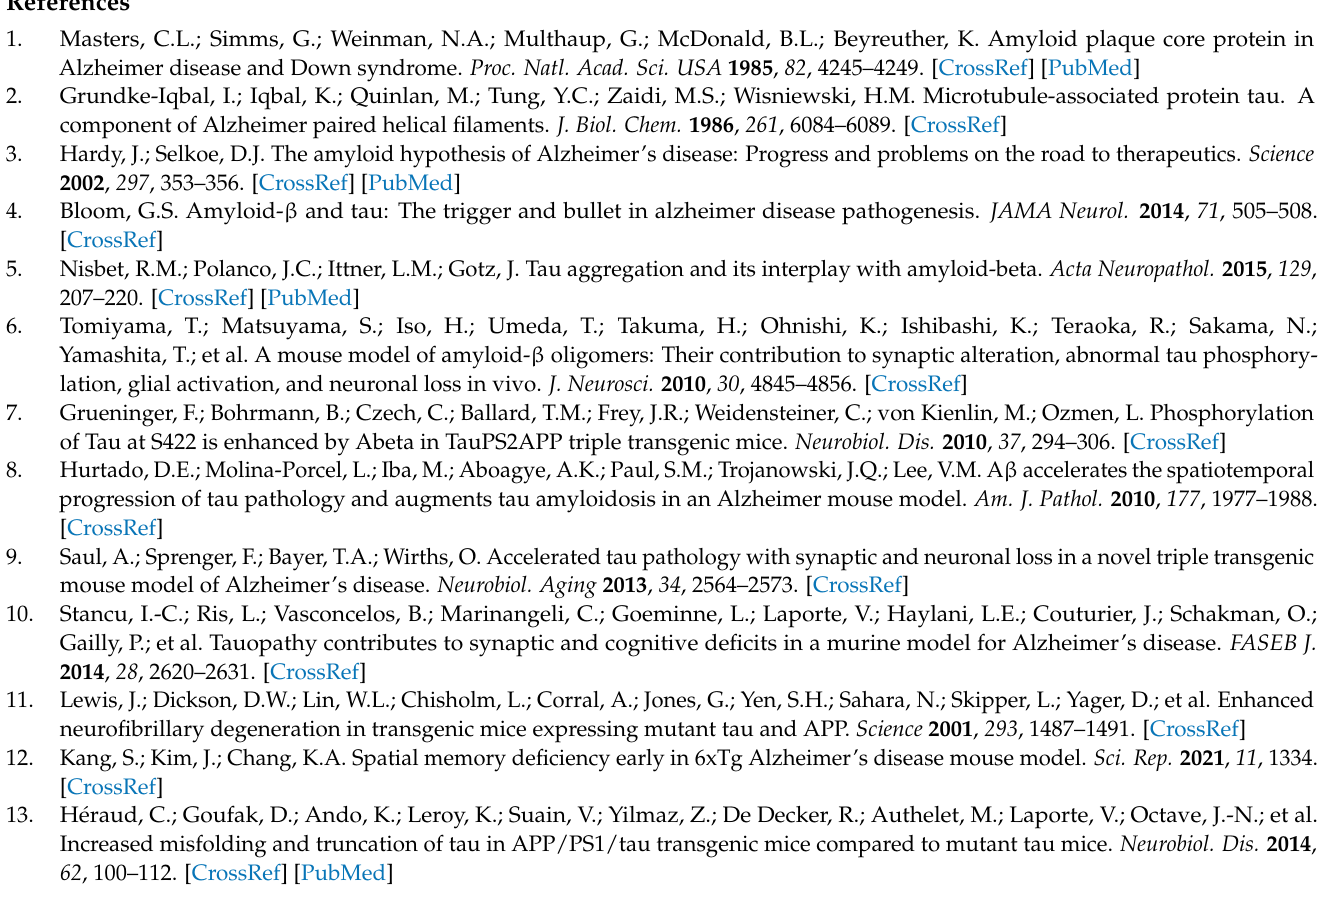
Figure S2: Water Maze—Speed in acquisition training, Figure S3: Water Maze—Time in target quadrant, Figure S4: Novel object recognition task, Figure S5: Examples of proximal and distal CA1, Figure S6: Neuron loss in total